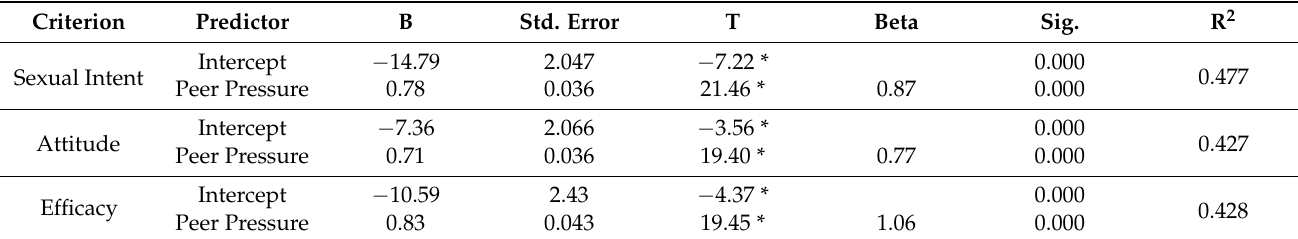
Table 3. Univariate analysis of the relationship between peer pressure and sexual adventurism dimensions. Criterion